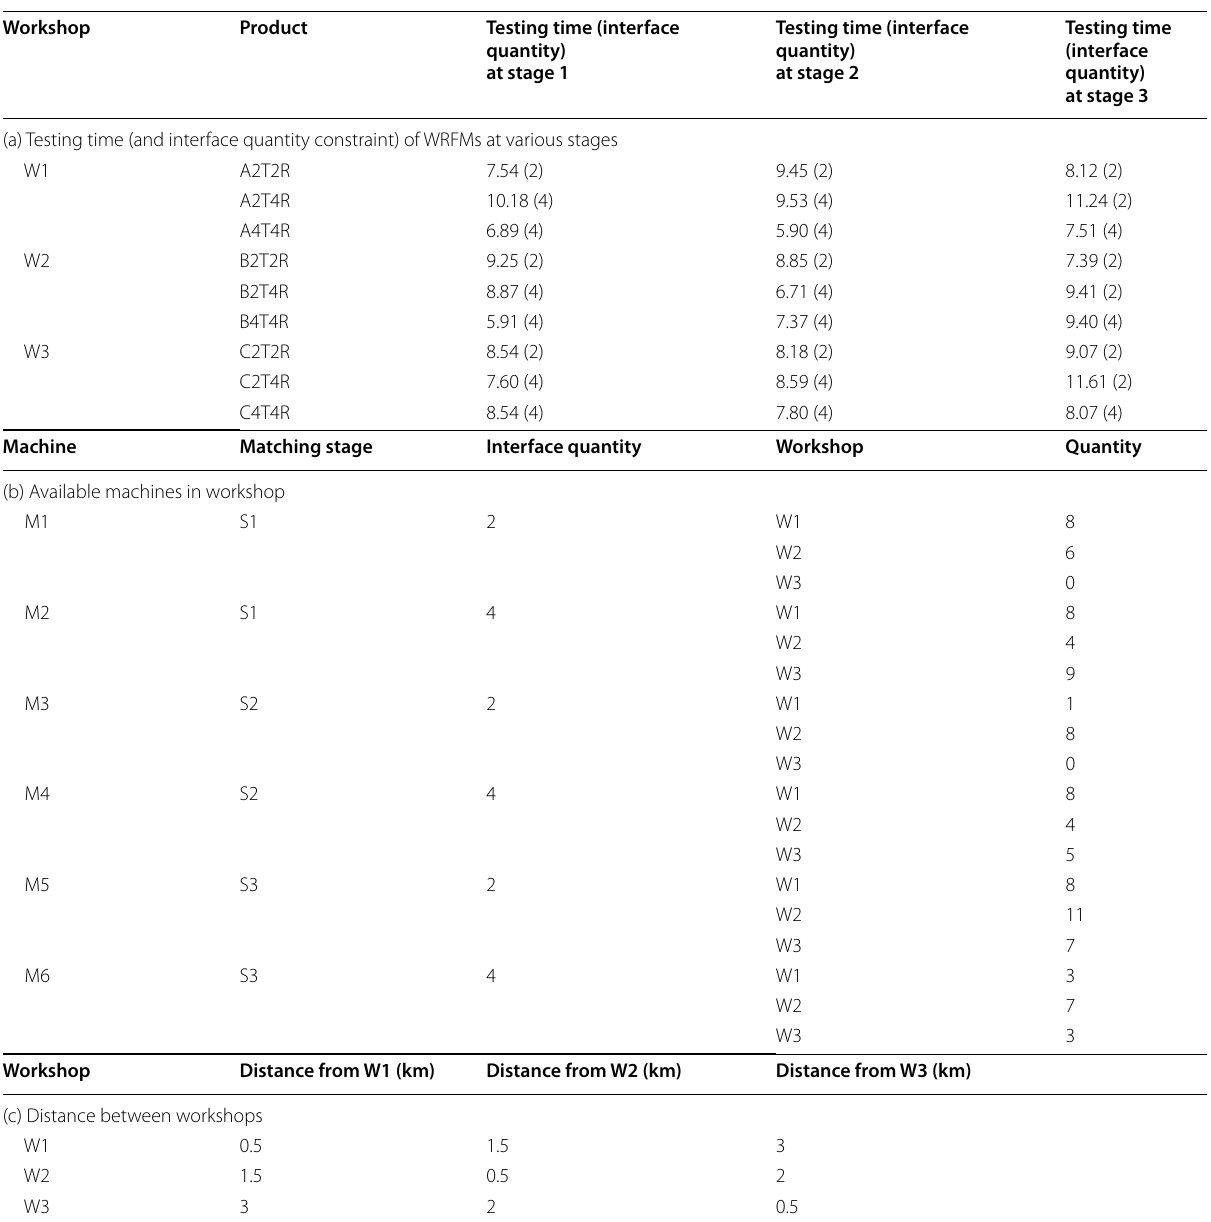
Table 8 Product and testing machine information